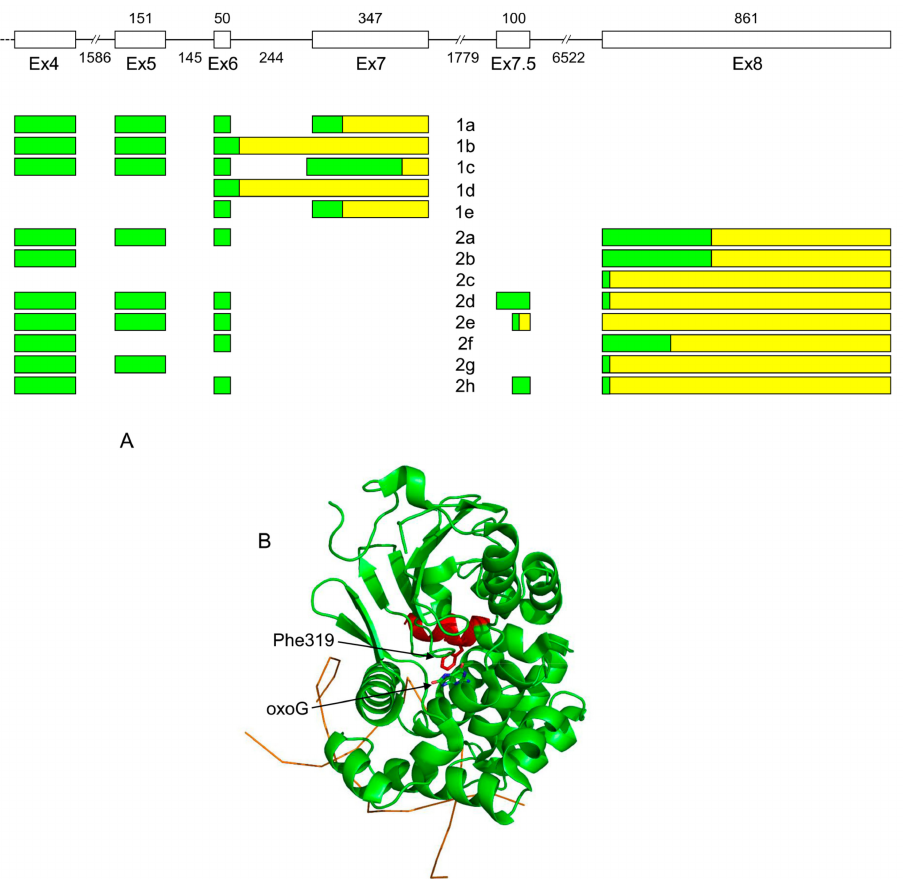
Figure 2. ( A ) Organization of exons 4–8 and alternative splicing products of the human OGG1 gene. ( B ) Structure of OGG1-1a protein (PDB ID 1EBM, [98]). DNA backbone is shown schematically as an orange line. The protein part encoded by exon 7 and thus missing in OGG1-1b and all group 2 isoforms are colored red. Phe319 forms a wall of the enzyme active site and stacks against the oxoG base; these interactions have to be remodeled in OGG1 group 2. Untranslated regions are yellow, coding sequences are